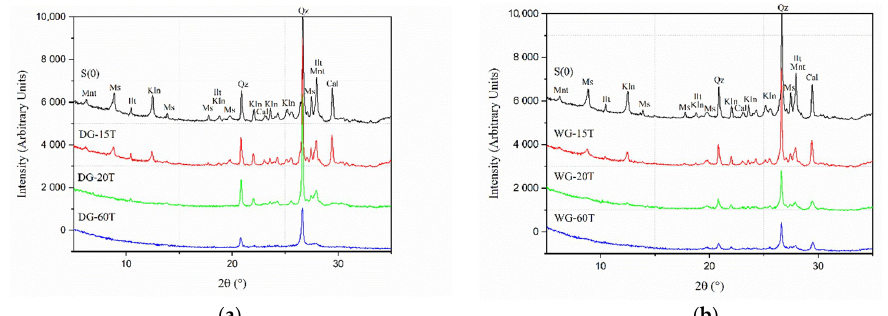
Figure 6. XRD diffraction patterns for different time grinding of a Swedish raw clay ( a ) dry grinding of samples S0, DG-15T and DG-20T, and ( b ) wet grinding of samples S0, WG-15T, WG-20T, and WG-60T.